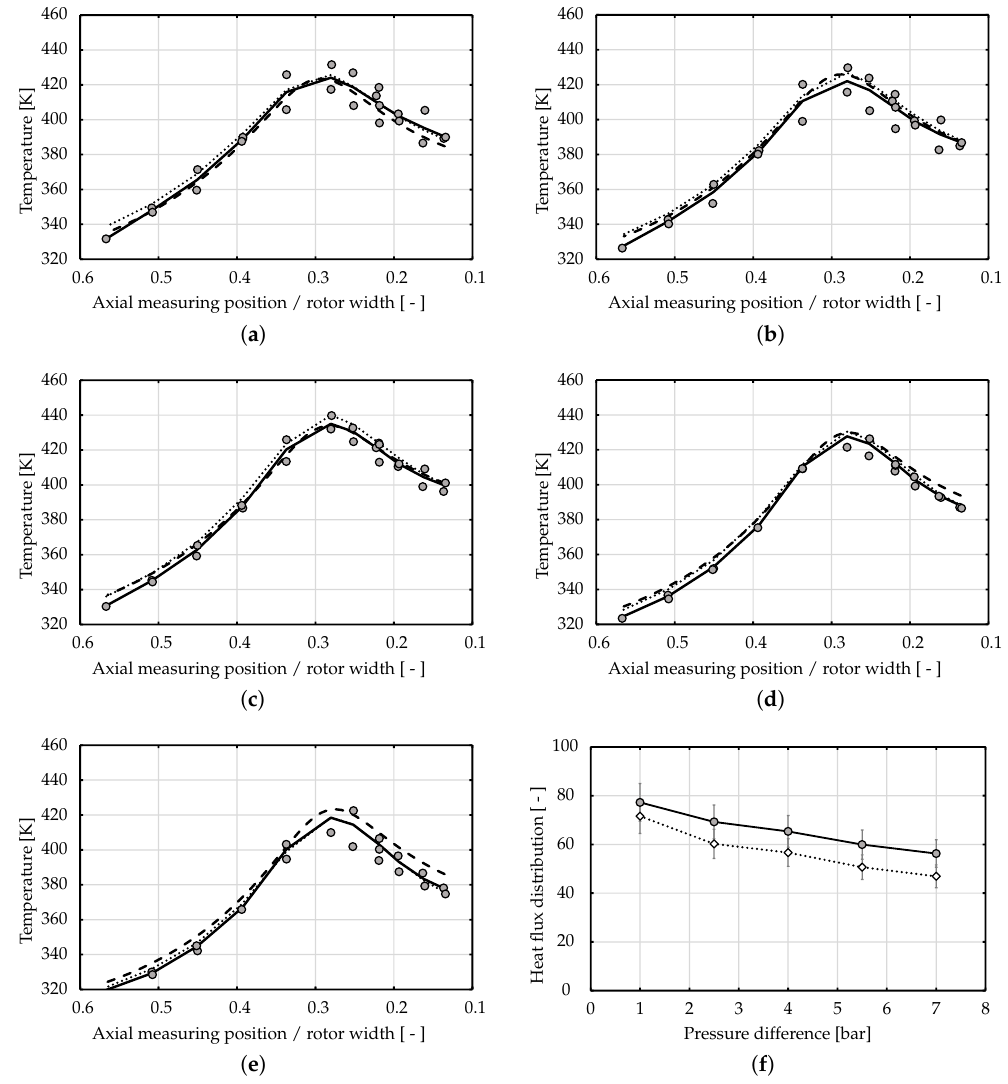
Figure 13. ( a – e ): Measuring points from experiment ( ), Fit of the measured values from experiment ( ), FE-Analysis ( ), CFD ( ); ( f ): Heat flux distribution under variation of the pressure differ- ence, Experiment ( ), CFD ( ), ( a ) ∆ p = 1.0bar, ( b ) ∆ p = 2.5bar, ( c ) ∆ p = 4.0bar, ( d ) ∆ p = 5.5bar, ( e ) ∆ p =